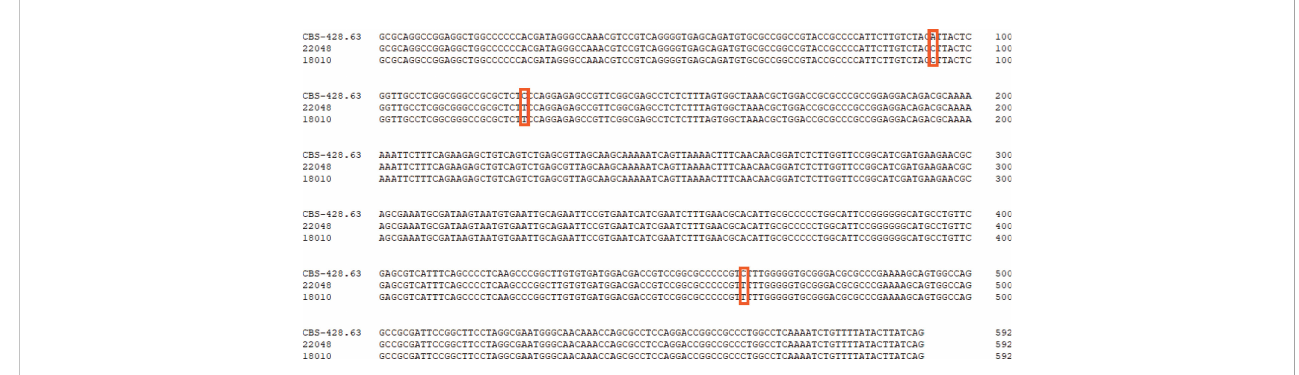
FIGURE 4 Comparison of the ITS regions of the nucleotide sequences of the isolate of JYP22048, JYP22010 and T. interdigitale CBS 428.63 (NR_144900). Boxes indicate speci fi c SNP between high TRF-resistance strains and the reference strains of T. interdigitale .